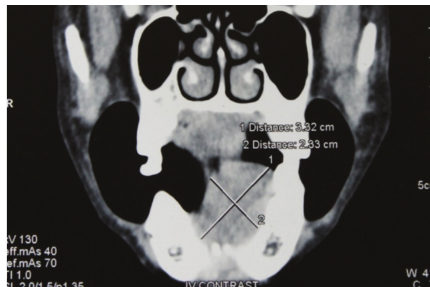
Figure 2: Axial CT shows dense mass of 3.32 cmm 2.33 cmm in the floor of the mouth.